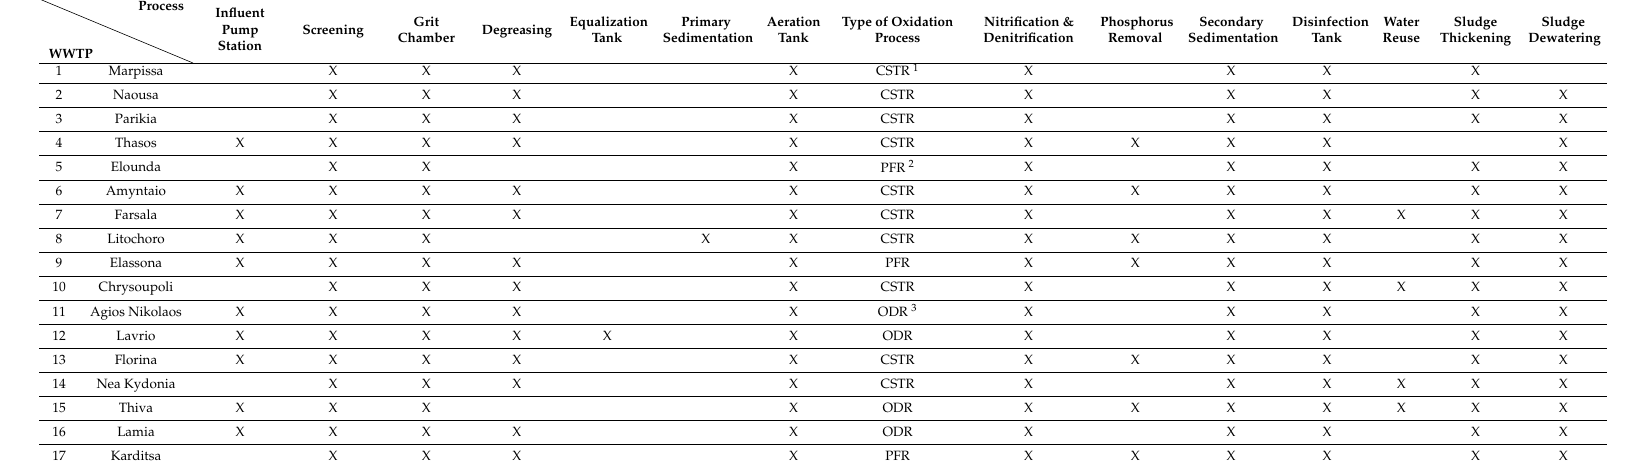
Table 1. Sub-processes for every WWTP participated to the study.